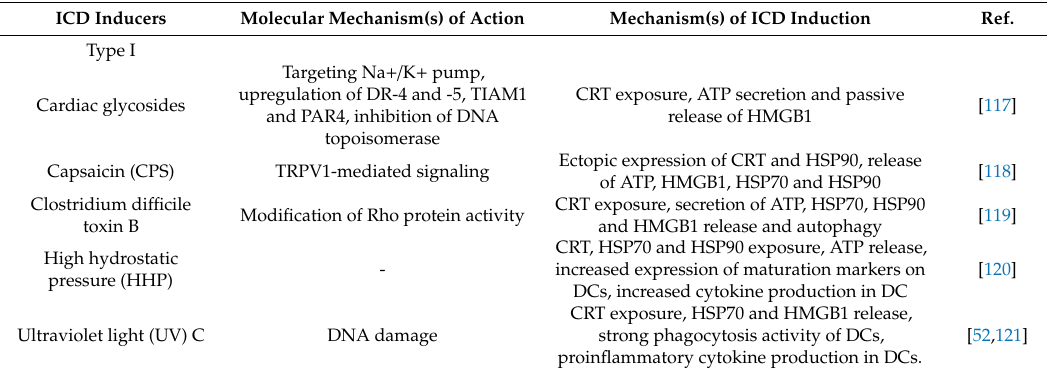
Table 1. Type I and type II inducers of immunogenic cell